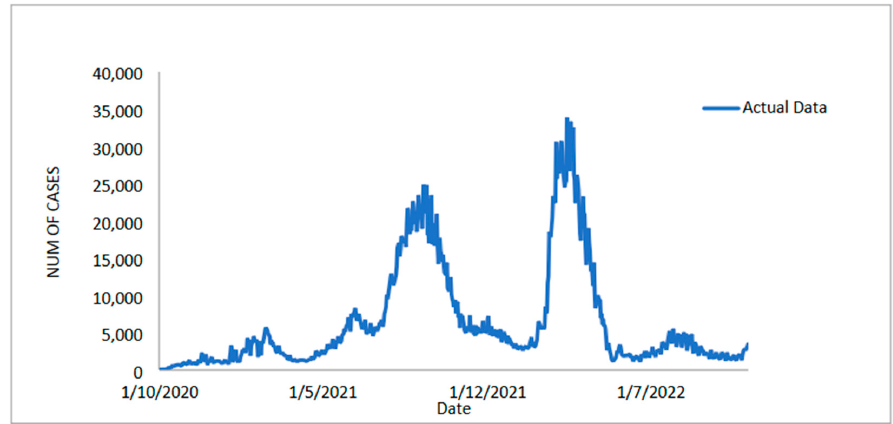
Figure 10. Malaysian daily new recovered COVID-19 cases (1 October 2020 to 4 November 2022). However, around March–April 2022, the number of recovered COVID-19 cases increased again to a maximum of 33,872.00, then decreased and showed a relatively stable movement after that. This dataset is also divided into two samples, namely the training dataset and the test dataset. The training dataset, which included 612 observations (80%) from 1 October 2020 to 4 June 2022, was used in the same way as the previous datasets